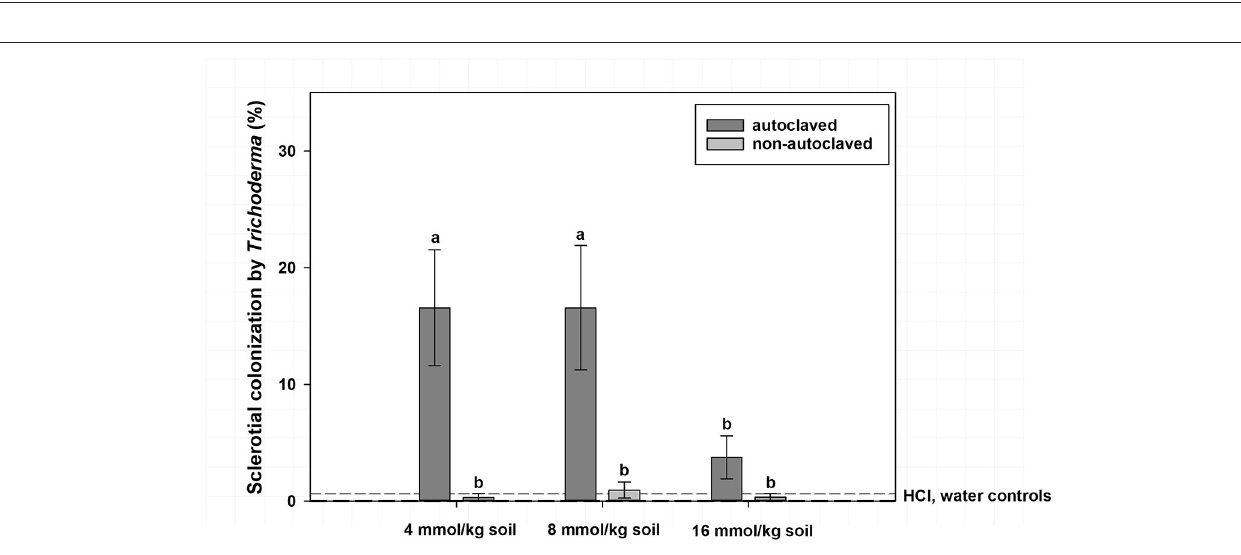
FIGURE 2 | Mean percentage colonization of A. rolfsii sclerotia by Trichoderma spp. in experiment 1 as affected by volatile fatty acid (VFA) concentration and soil autoclaving. Bars indicated by the same letter are not significantly different according to an F-protected LSD at P ≤ 0.05. Error bars represent standard error of the